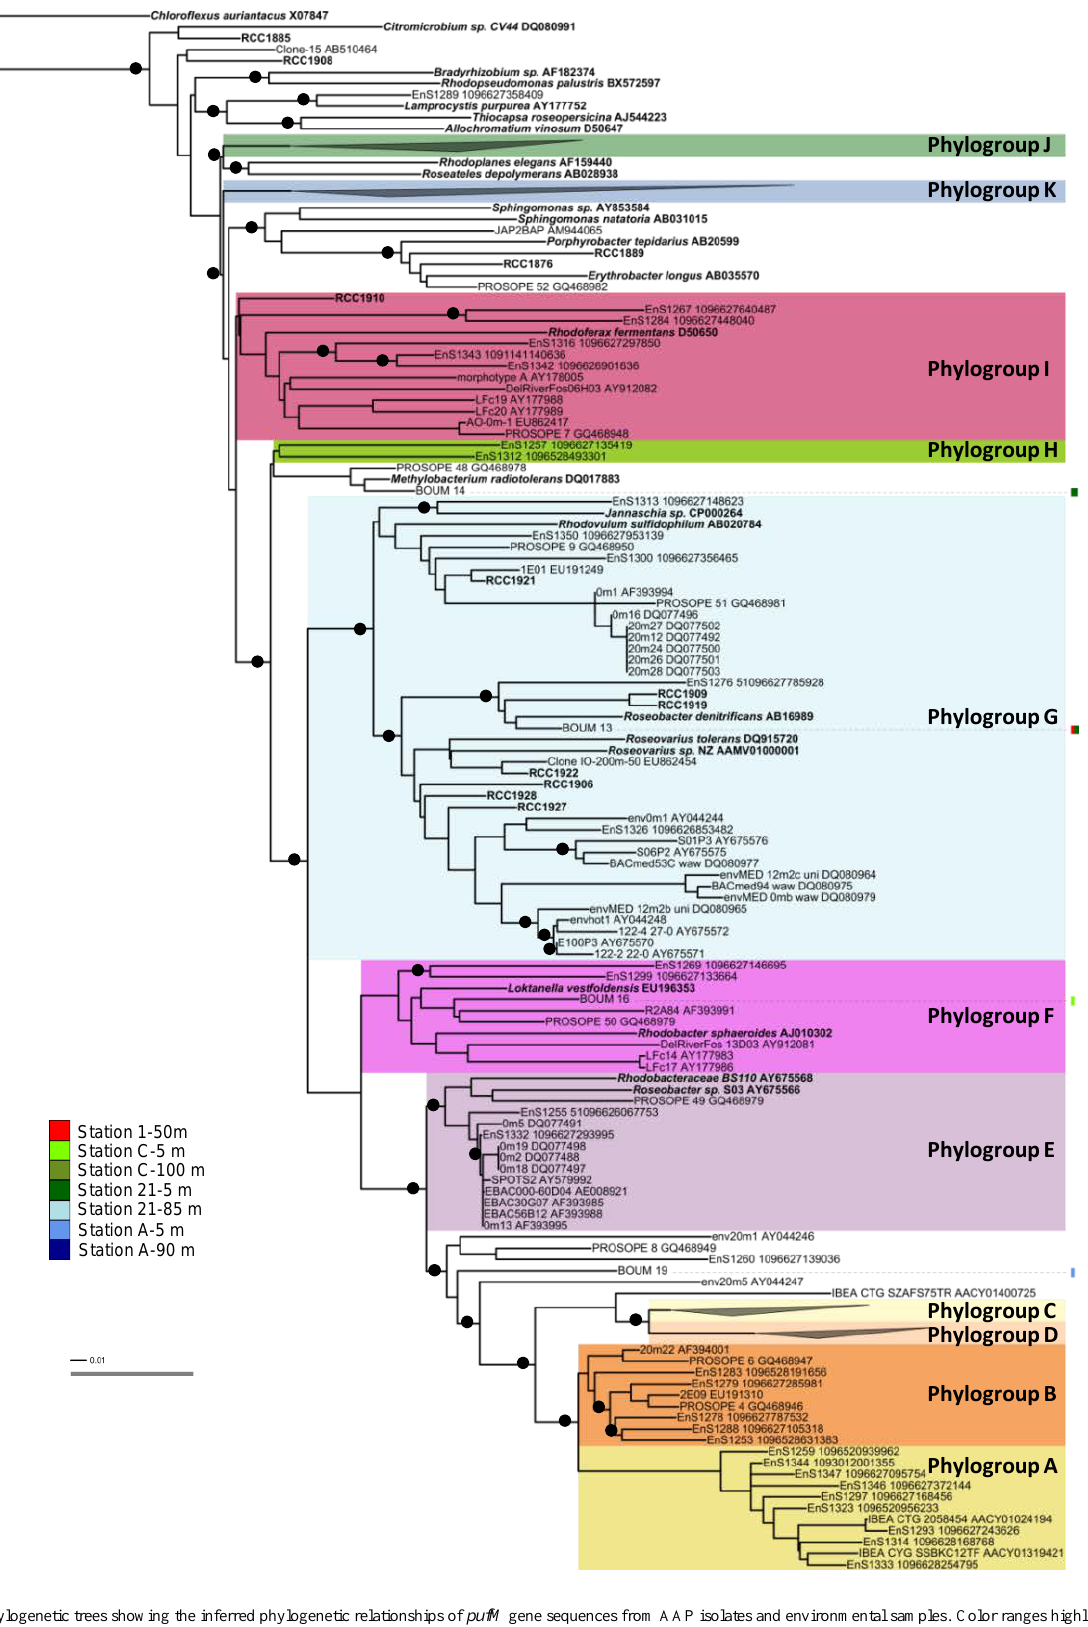
Fig. 3a. pufM phylogenetic trees showing the inferred phylogenetic relationships of pufM gene sequences from AAP isolates and environmental samples. Color ranges highlight the different groups defined by Yutin et al. (2007). (a) Phylogenetic relationships of pufM genes affiliated to phylogroups F, G, I and to unidentified